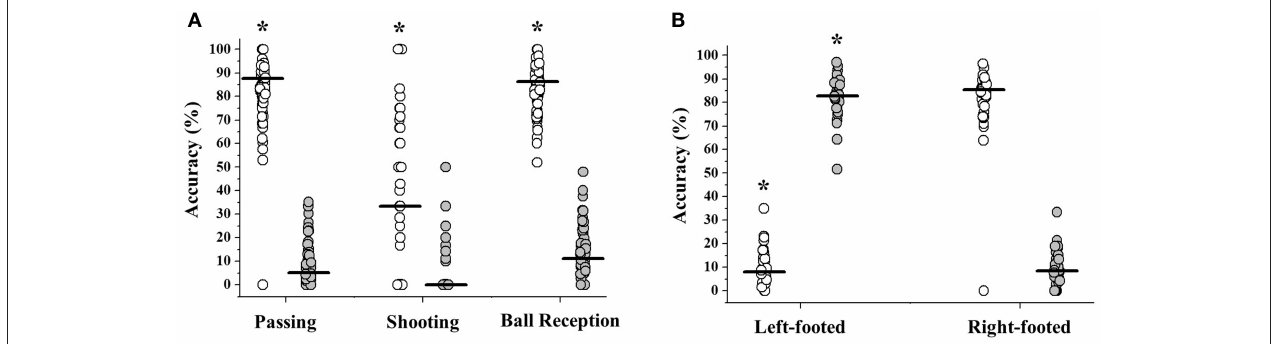
Supplementary Table 3 . Regardless of the quality of